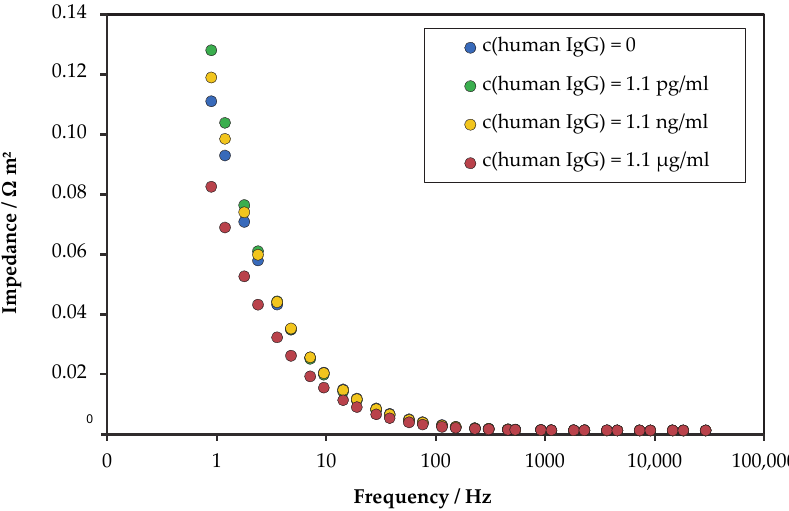
Figure 6. EIS impedance over frequency for the four different concentrations of human IgG antigen in the electrolyte, using BDD with biosensing surface as working electrode; arithmetical mean values